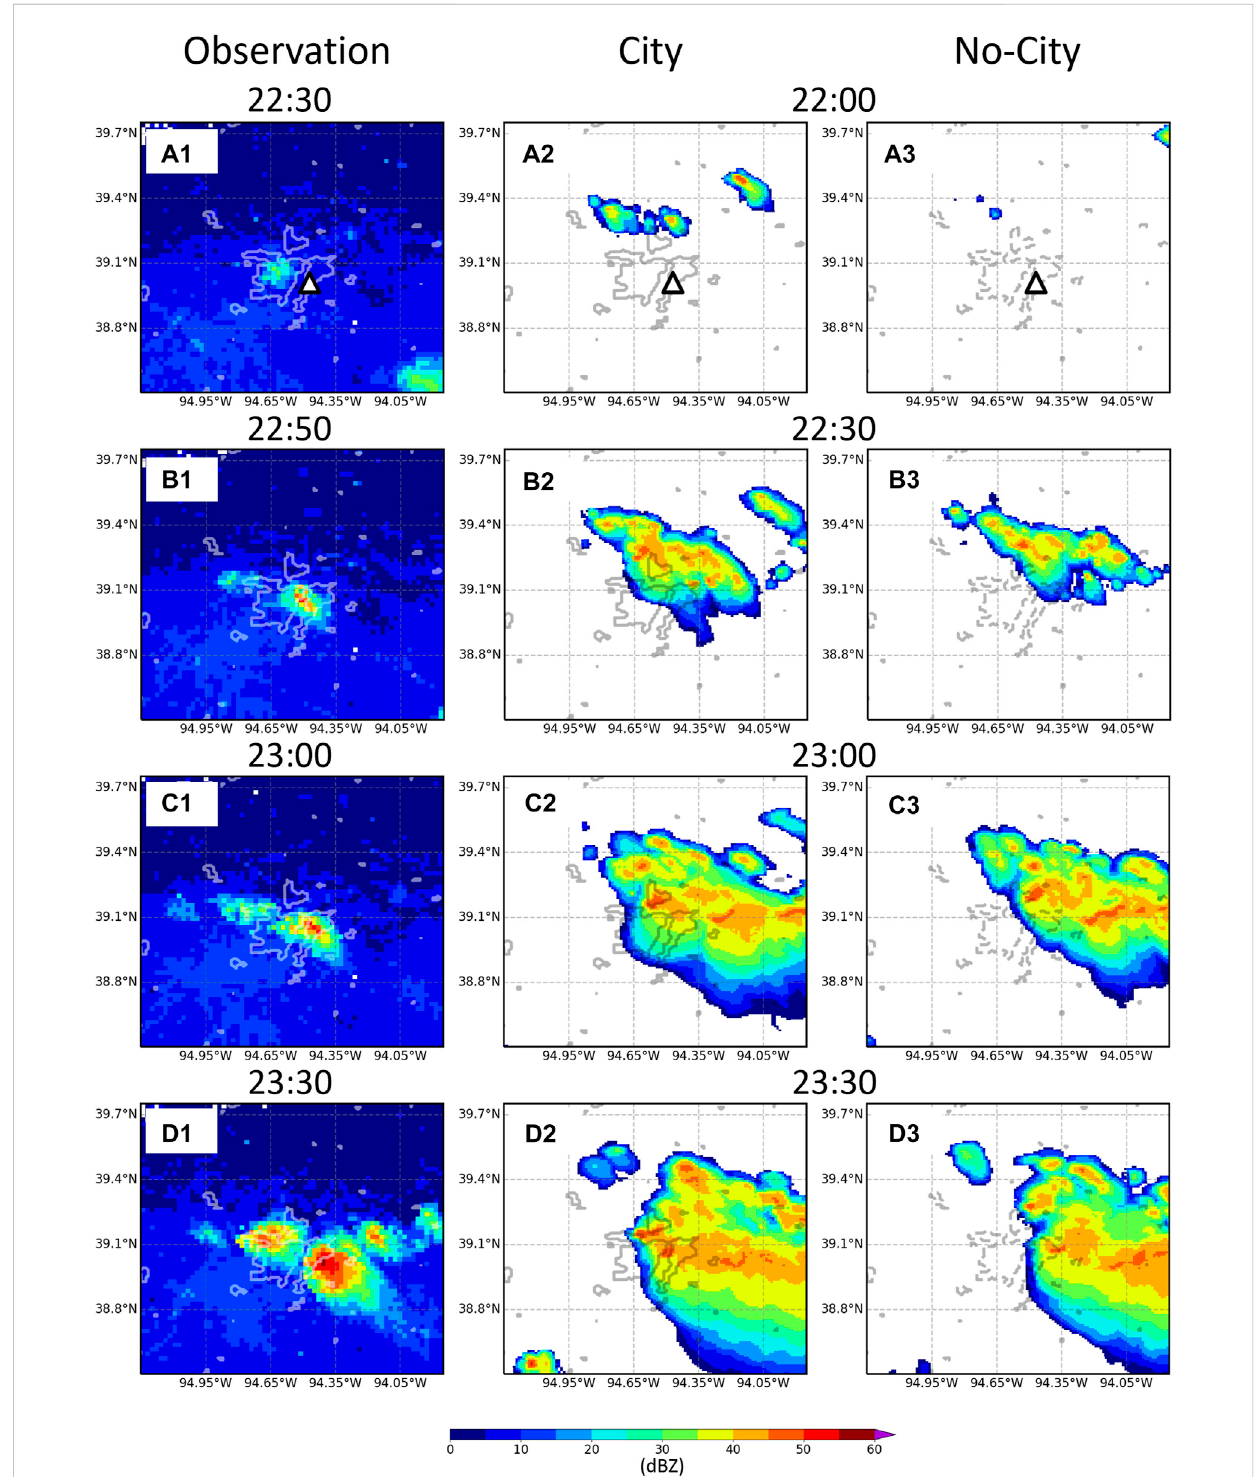
FIGURE 2 Evolution of radar re fl ectivity for (A1 – A3) observation, (B1 – B3) City simulation, and (C1 – C3) No-City simulation. The time steps are not exactly matched between observation and simulations because the simulated storm initiated about 50 min earlier and grew slower relative to the observed one. The white triangle in (D1 – D3) indicates the location of the fi rst tornado report at 23:33